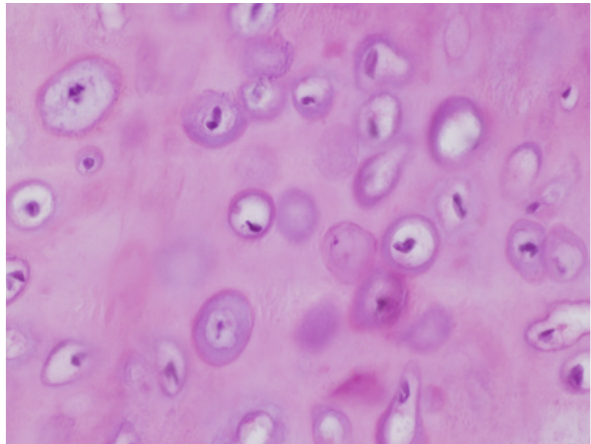
Fig. 1. Detail of several malignant chondrocytes with thick perichondrocytic rings as they were observed in mesenchymal chondrosarcoma. HE, x100.